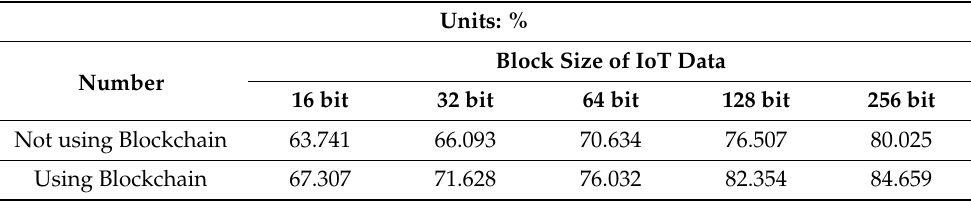
Table 5. Storage rate according to hash code length of IoT data